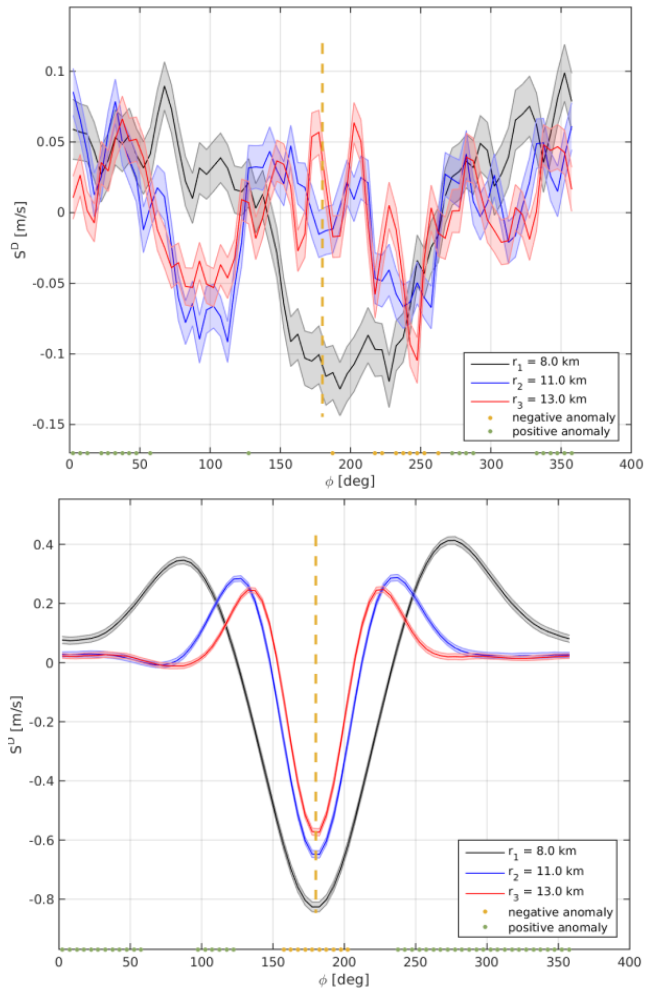
Figure 13. Similar to Figure 10 but for Horns Rev